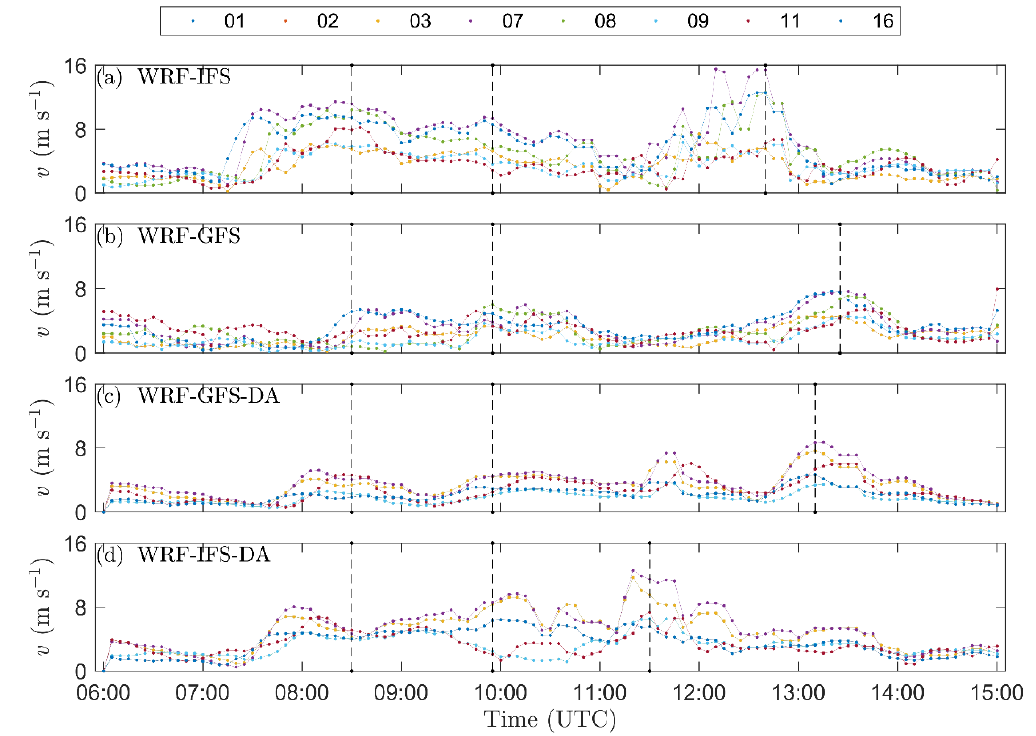
Figure 17. Maximum 5-min wind speeds at 10 m above ground at the eight anemometers location in the Genoa port (see Figures 2 and 11 for anemometer locations and measurements, respectively): ( a ) WRF-IFS; ( b ) WRF-GFS; ( c ) WRF-GFS-DA; ( d ) WRF-IFS-DA. The vertical dashed lines show the time instances used for the analysis of radar reflectivity and thermodynamics diagrams.